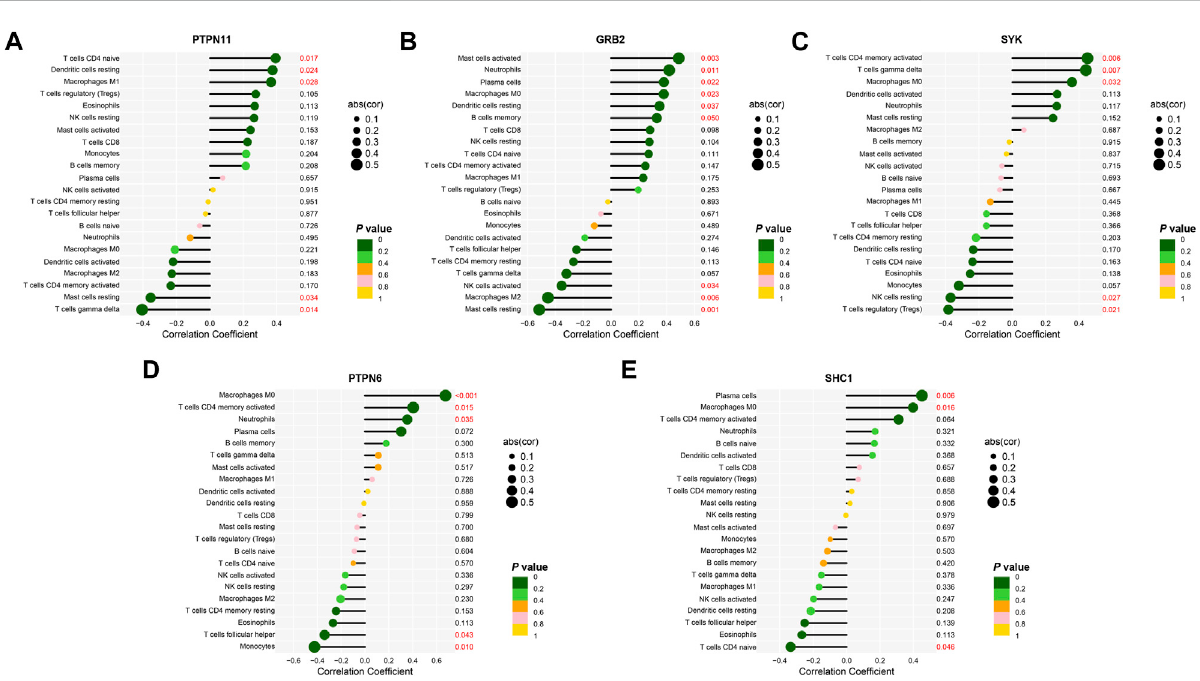
FIGURE 7 Correlations between the expression values of key DEIRGs and the relative fractions of immune cells in fi ltration. (A – E) Correlation analysis of the association between the expression values of PTPN11 , GRB2 , SYK , PTPN6 , SHC1 and the relative fractions of immune cells in fi ltration based on Spearman ’ s rank correlation